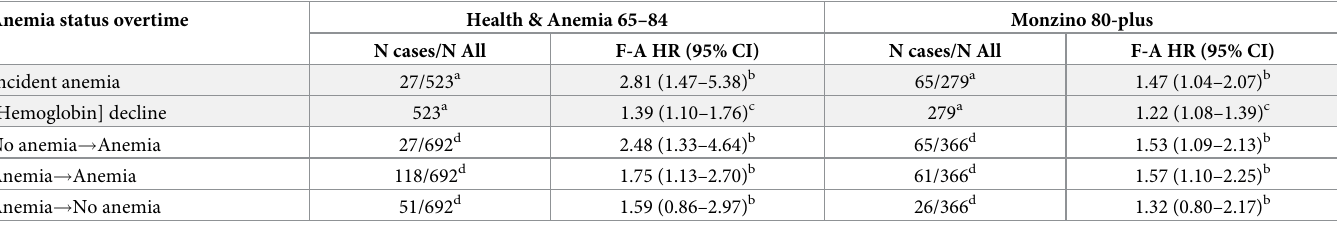
Table 4. Risk of mortality associated with incident anemia, decline in hemoglobin concentration, and change in anemia status in young-old and old-old participants with two blood samples over 7 years after the second blood